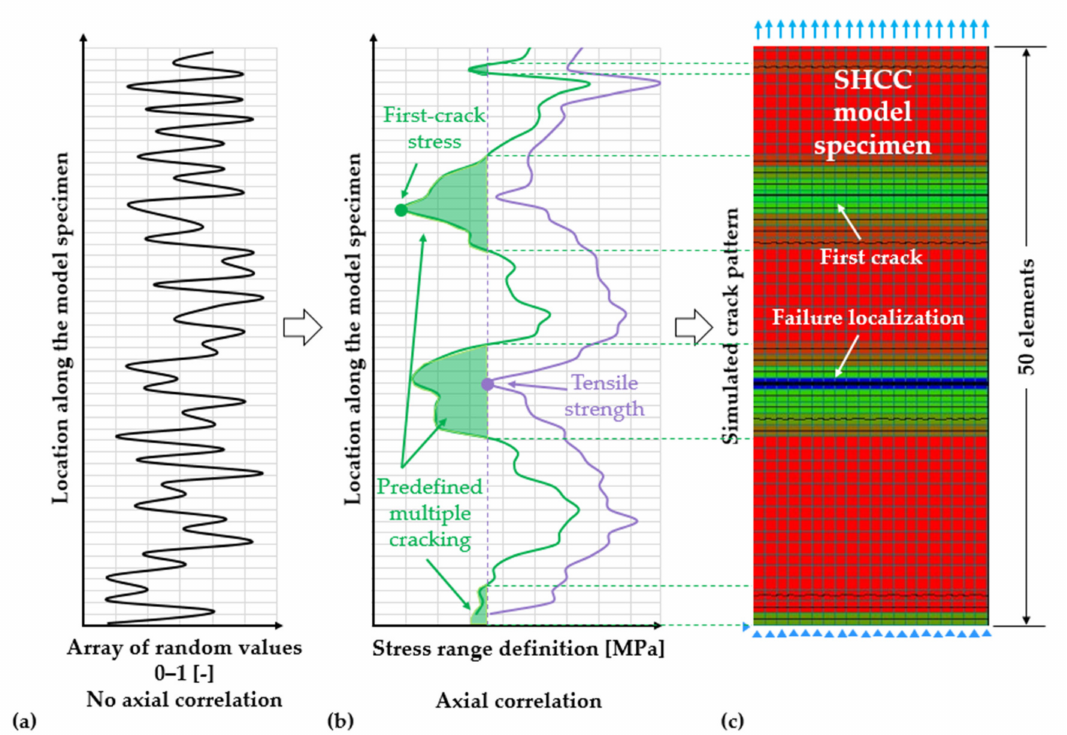
Figure 6. ( a ) Elementwise distribution of axially non-correlated probabilistic values generated within normalized boundaries. ( b ) Axial correlation and range definition for the matrix strength and tensile strength. ( c ) Effect of the probabilistic distribution and axial fluctuation of matrix strength and tensile strength, as well as of the range overlap of these parameters on the degree and regions of multiple cracking in a plain SHCC model